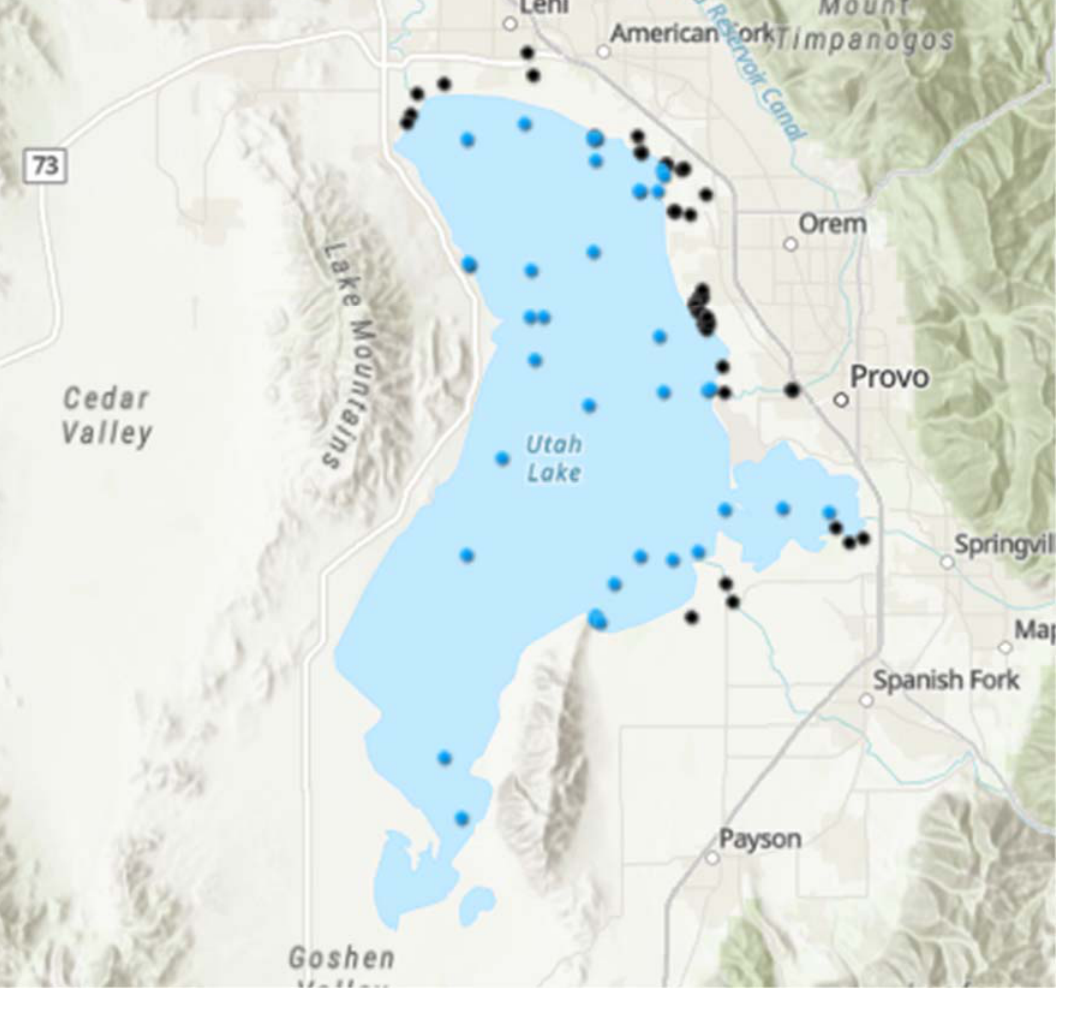
Table 3. Utah Lake AWQMS measurements included in WQDV for our case study.